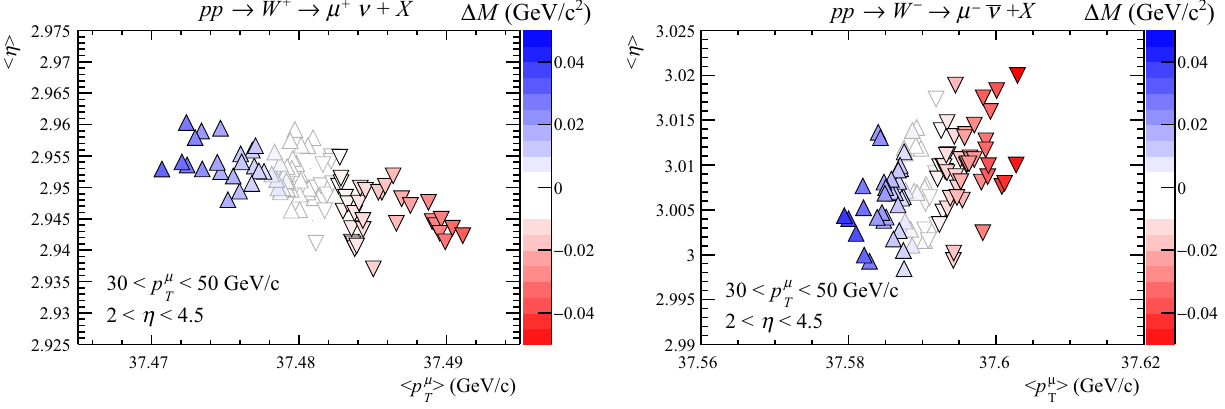
μ (cid:8) and (cid:7) η (cid:8) produced using a subset of Fig. 8 The distribution of (cid:7) p T replicas of the NNPDF3.1 set and divided by the central replica. Each marker is assigned a colour according to the shift of the M W value